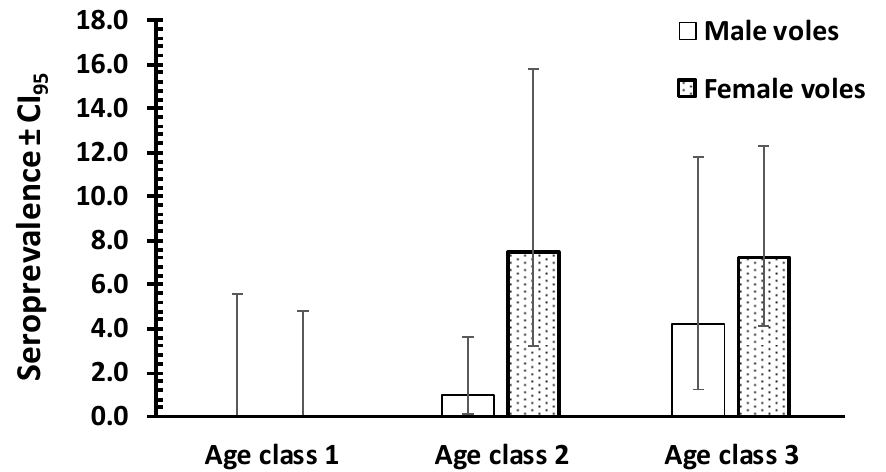
Figure 1. Seroprevalence of T. gondii in bank voles in Poland by host sex and by host age class (class 1—immature juvenile voles, n = 138; class 2—young adult voles, n = 173; and class 3—breeding older animals, n = 196). Error bars indicate 95% CI.